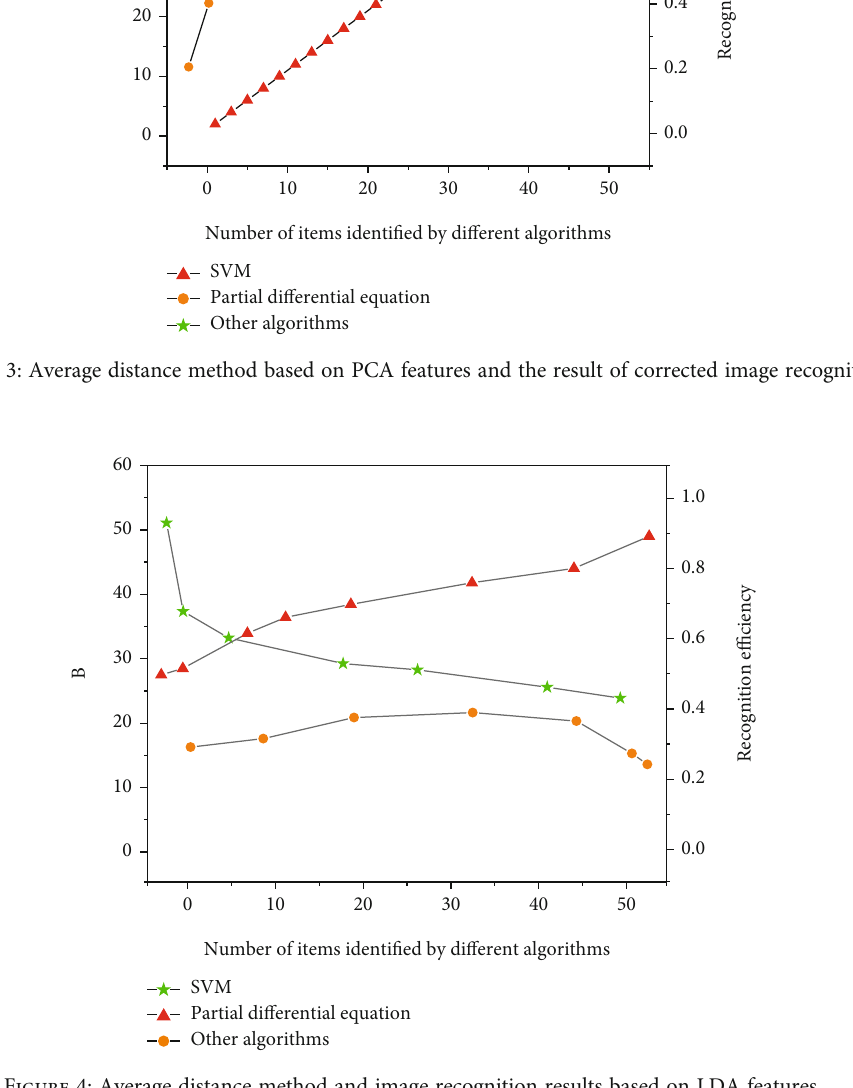
Figure 4: Average distance method and image recognition results based on LDA